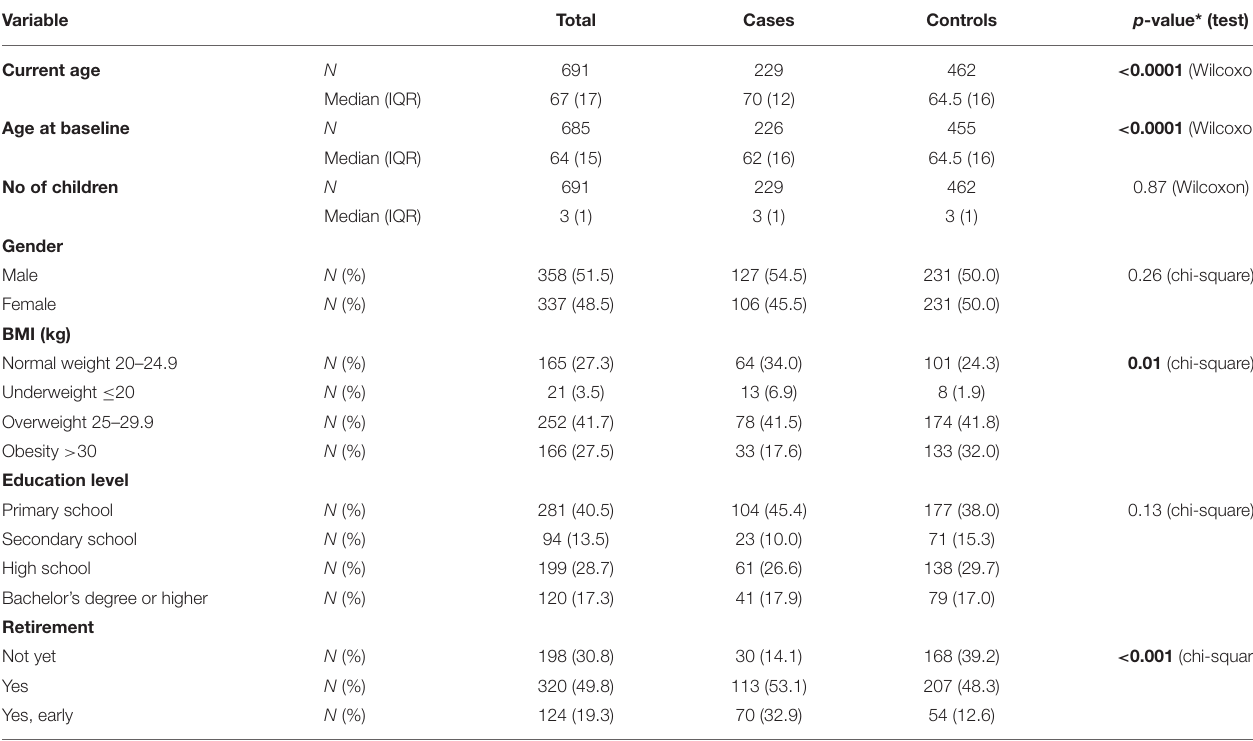
TABLE 1 | Demographic characteristics of Cypriot PD cases and controls.